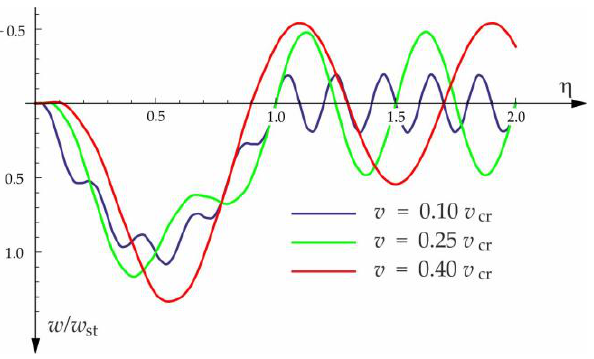
Figure 6. Influence of moving force velocity on the deflection of the midpoint of a beam on three-parameter inertial Vlasov foundation.